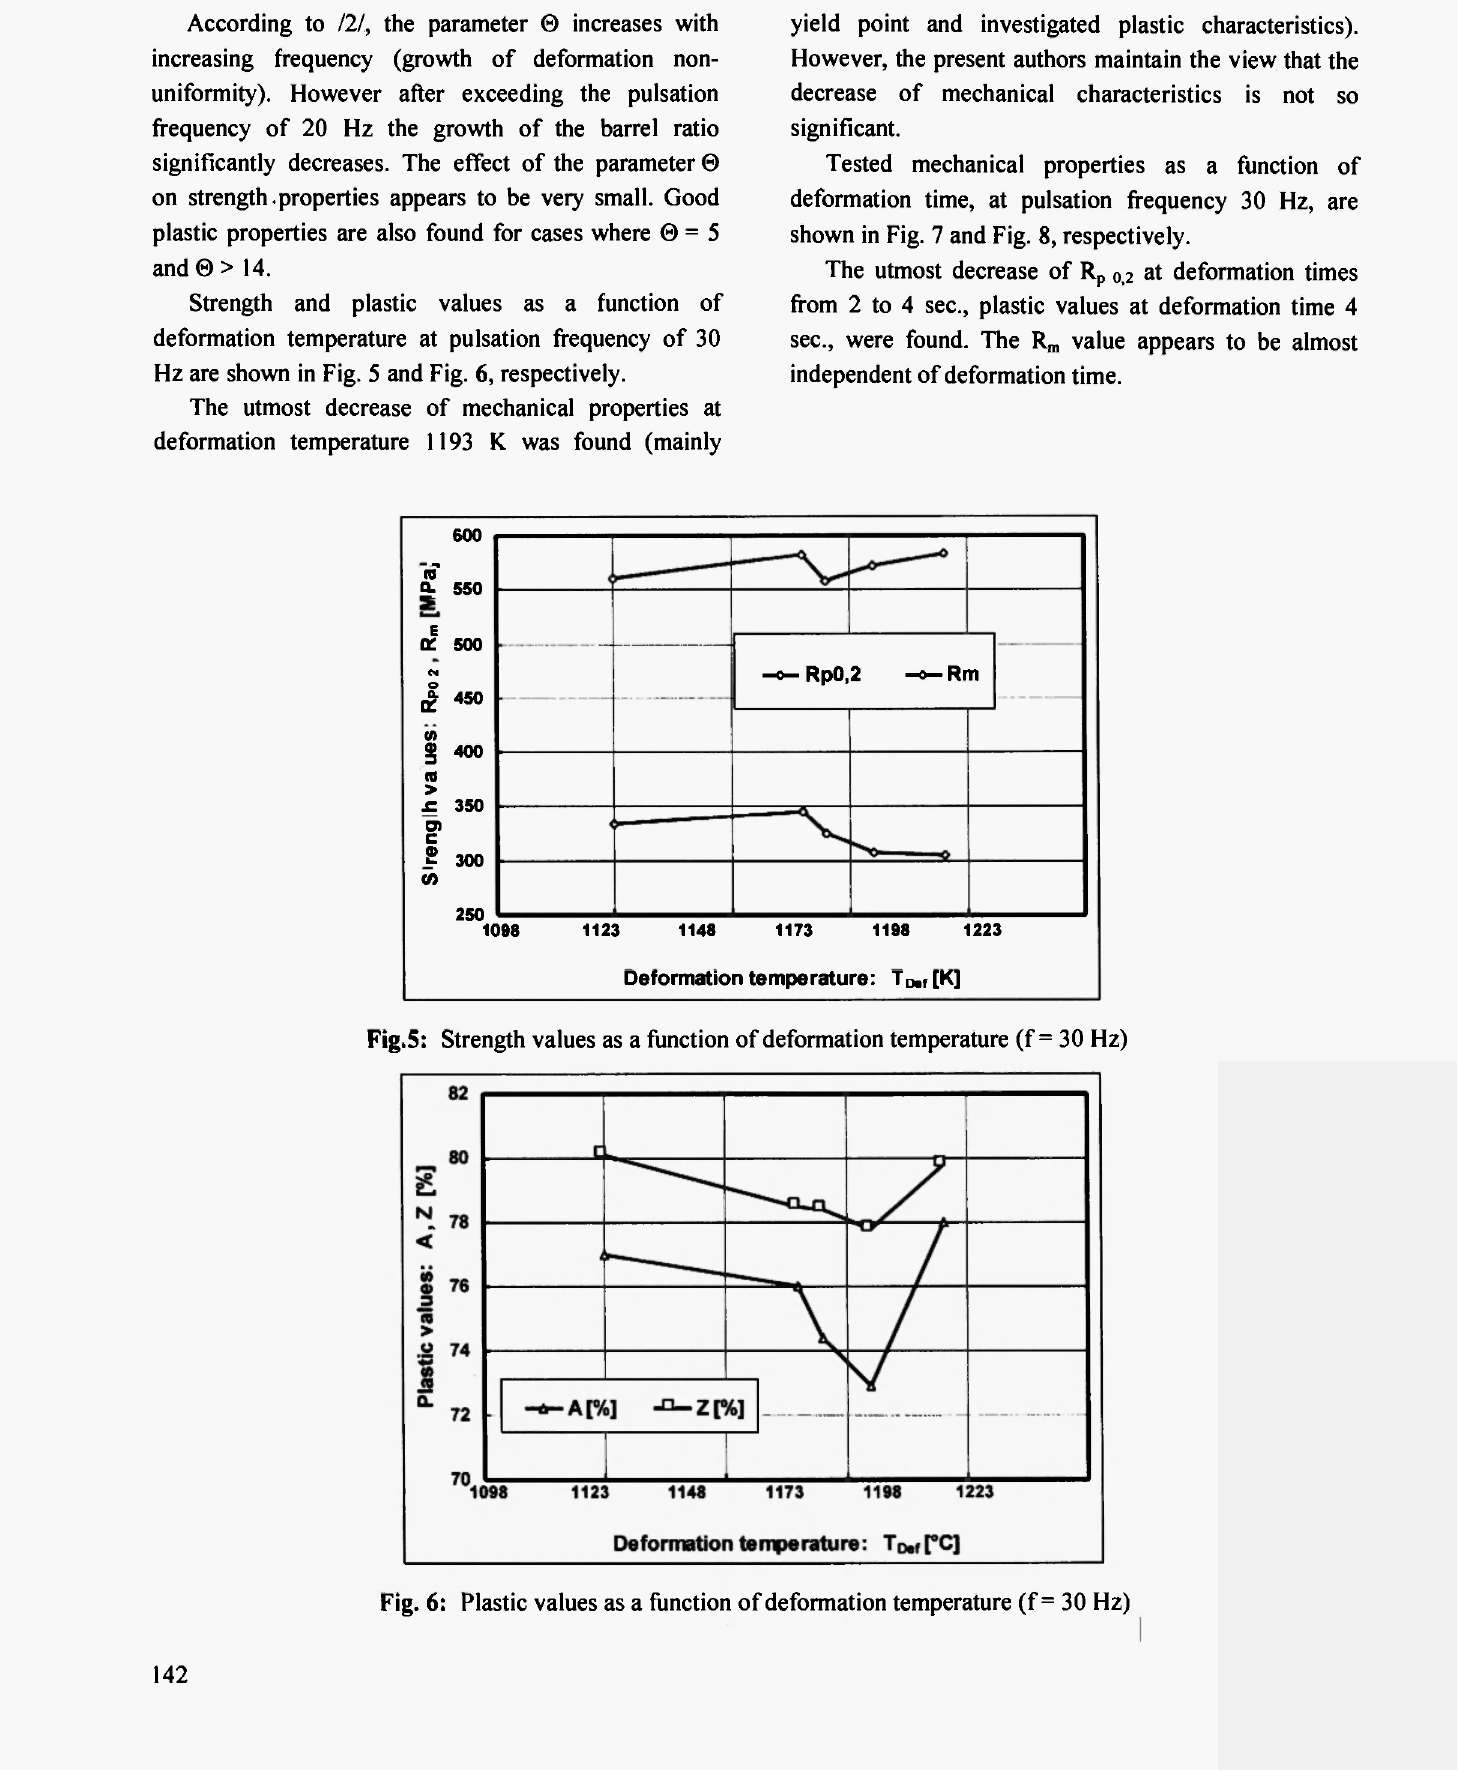
Fig.5: Strength values as a function of deformation temperature (f = 30 Hz)